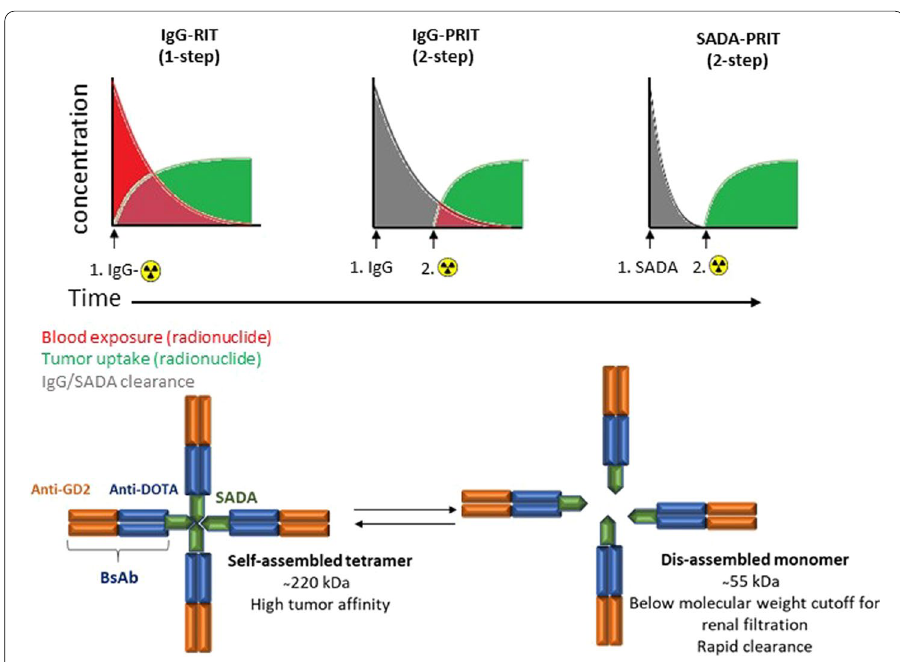
Fig. 3 Schematic overview of convential IgG‑radioimmunotherapy (IgG‑RIT) and 2‑step IgG‑pretargeted radioimmunotherapy (IgG‑PRIT), compared to self assembling and disassembling